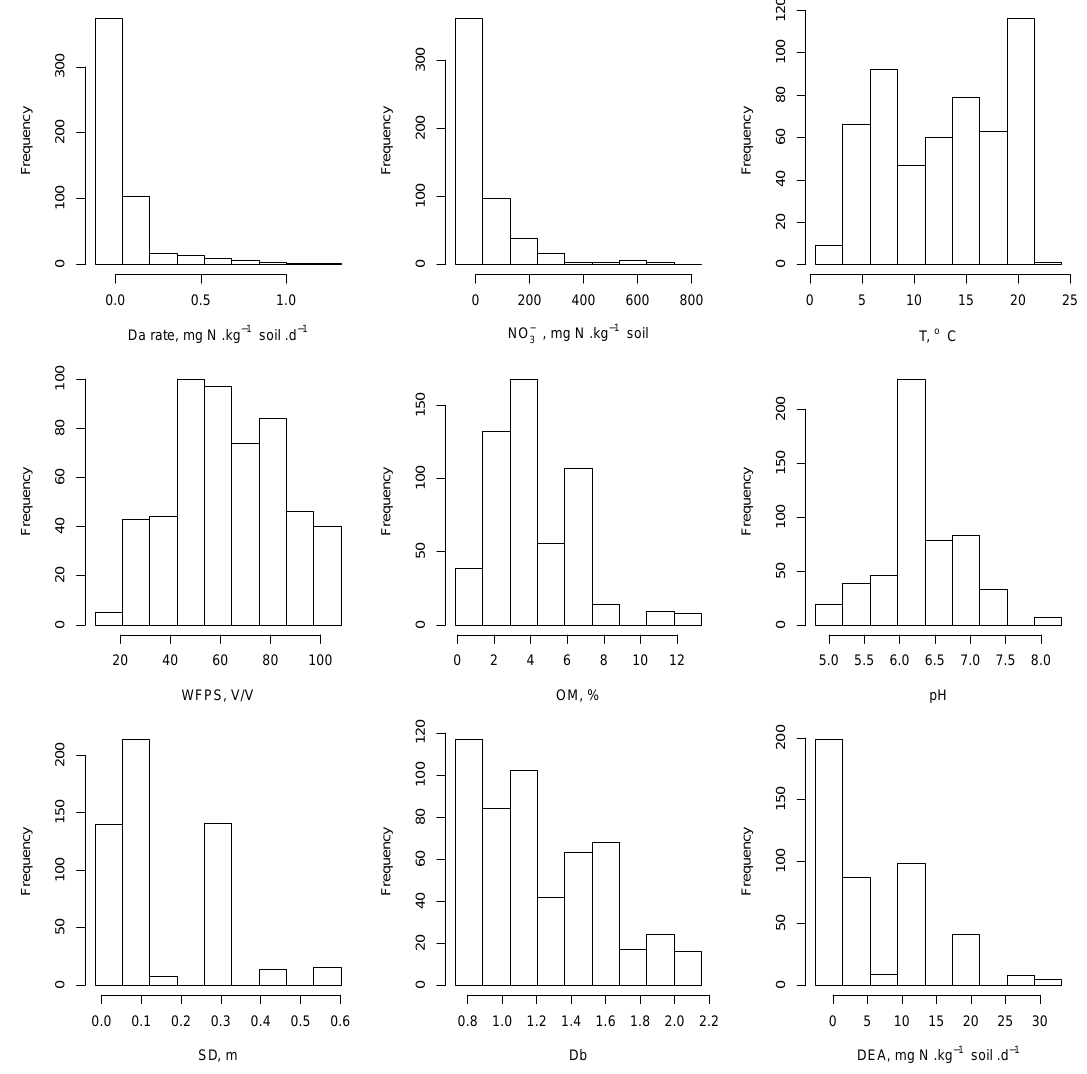
Fig. 1. Distribution of the variables in the database (536